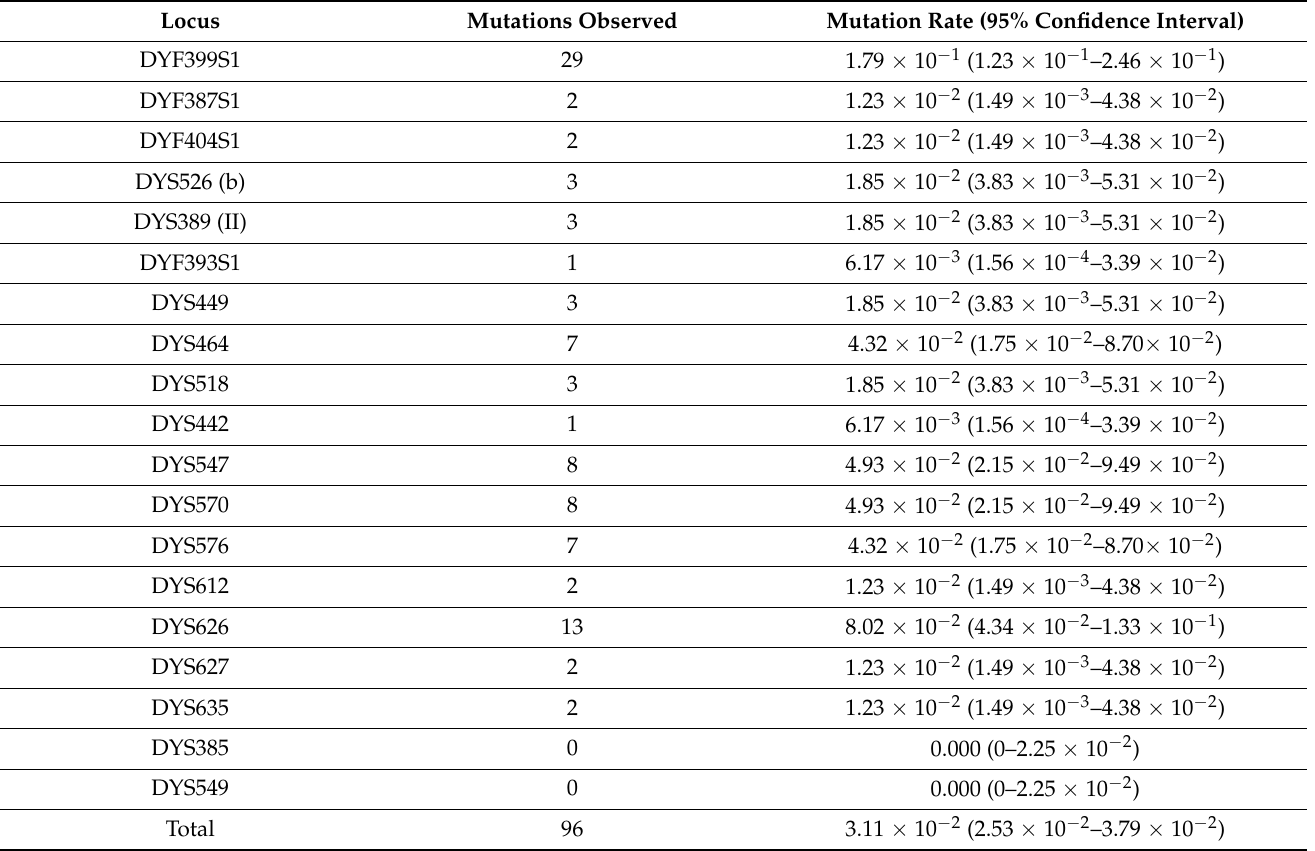
Table 1. Mutation rates observed at 19 loci in father–son pairs ( n = 162). Locus Mutations Observed Mutation Rate (95% Confidence